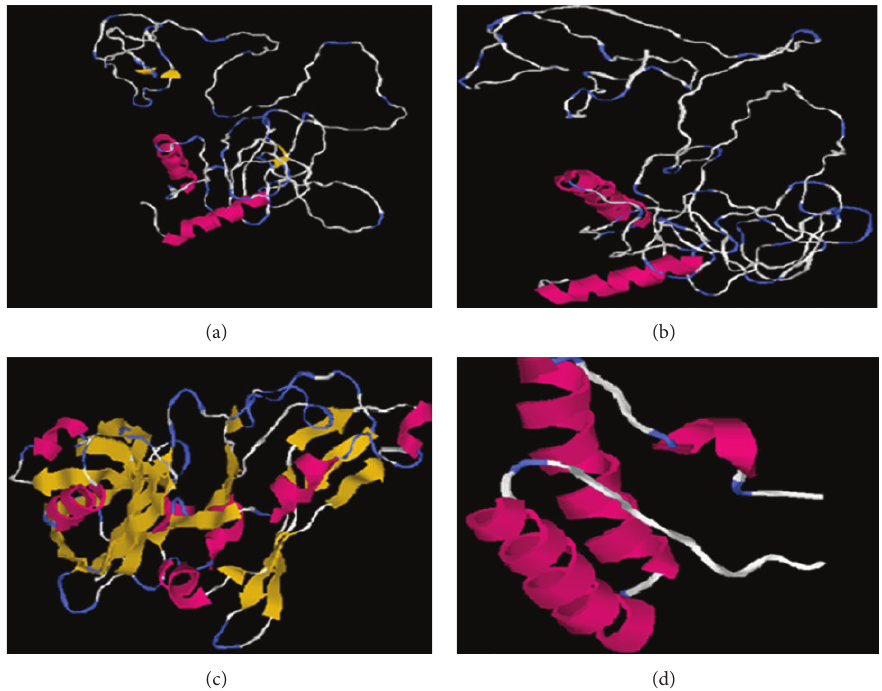
Figure 1: Modeled structures of (a) glycoprotein A, (b) glycoprotein B, (c) matrix protein, and (d) small hydrophobic